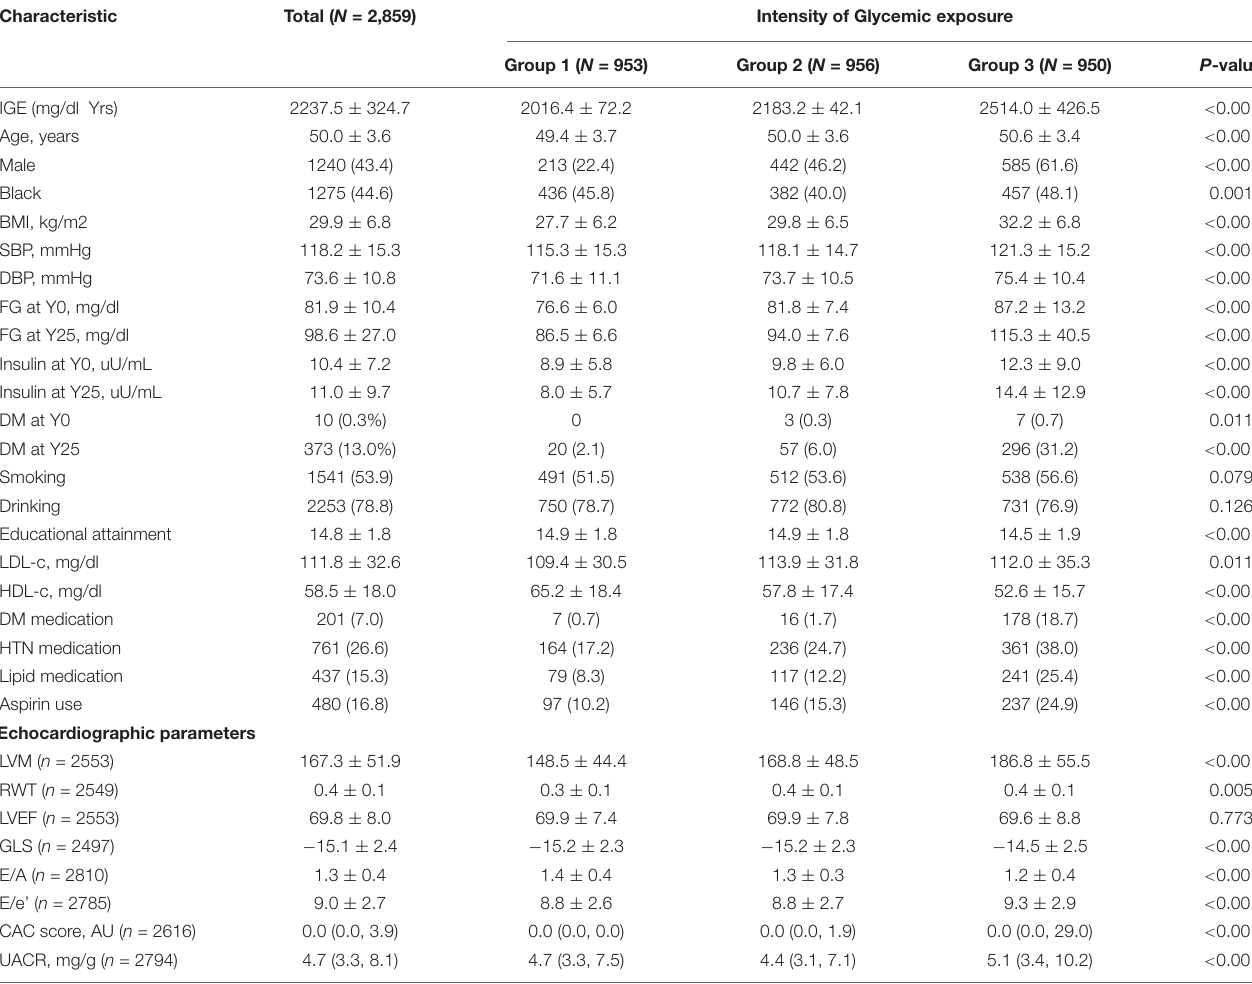
TABLE 1 | Baseline Characteristics for 2,859 CARDIA